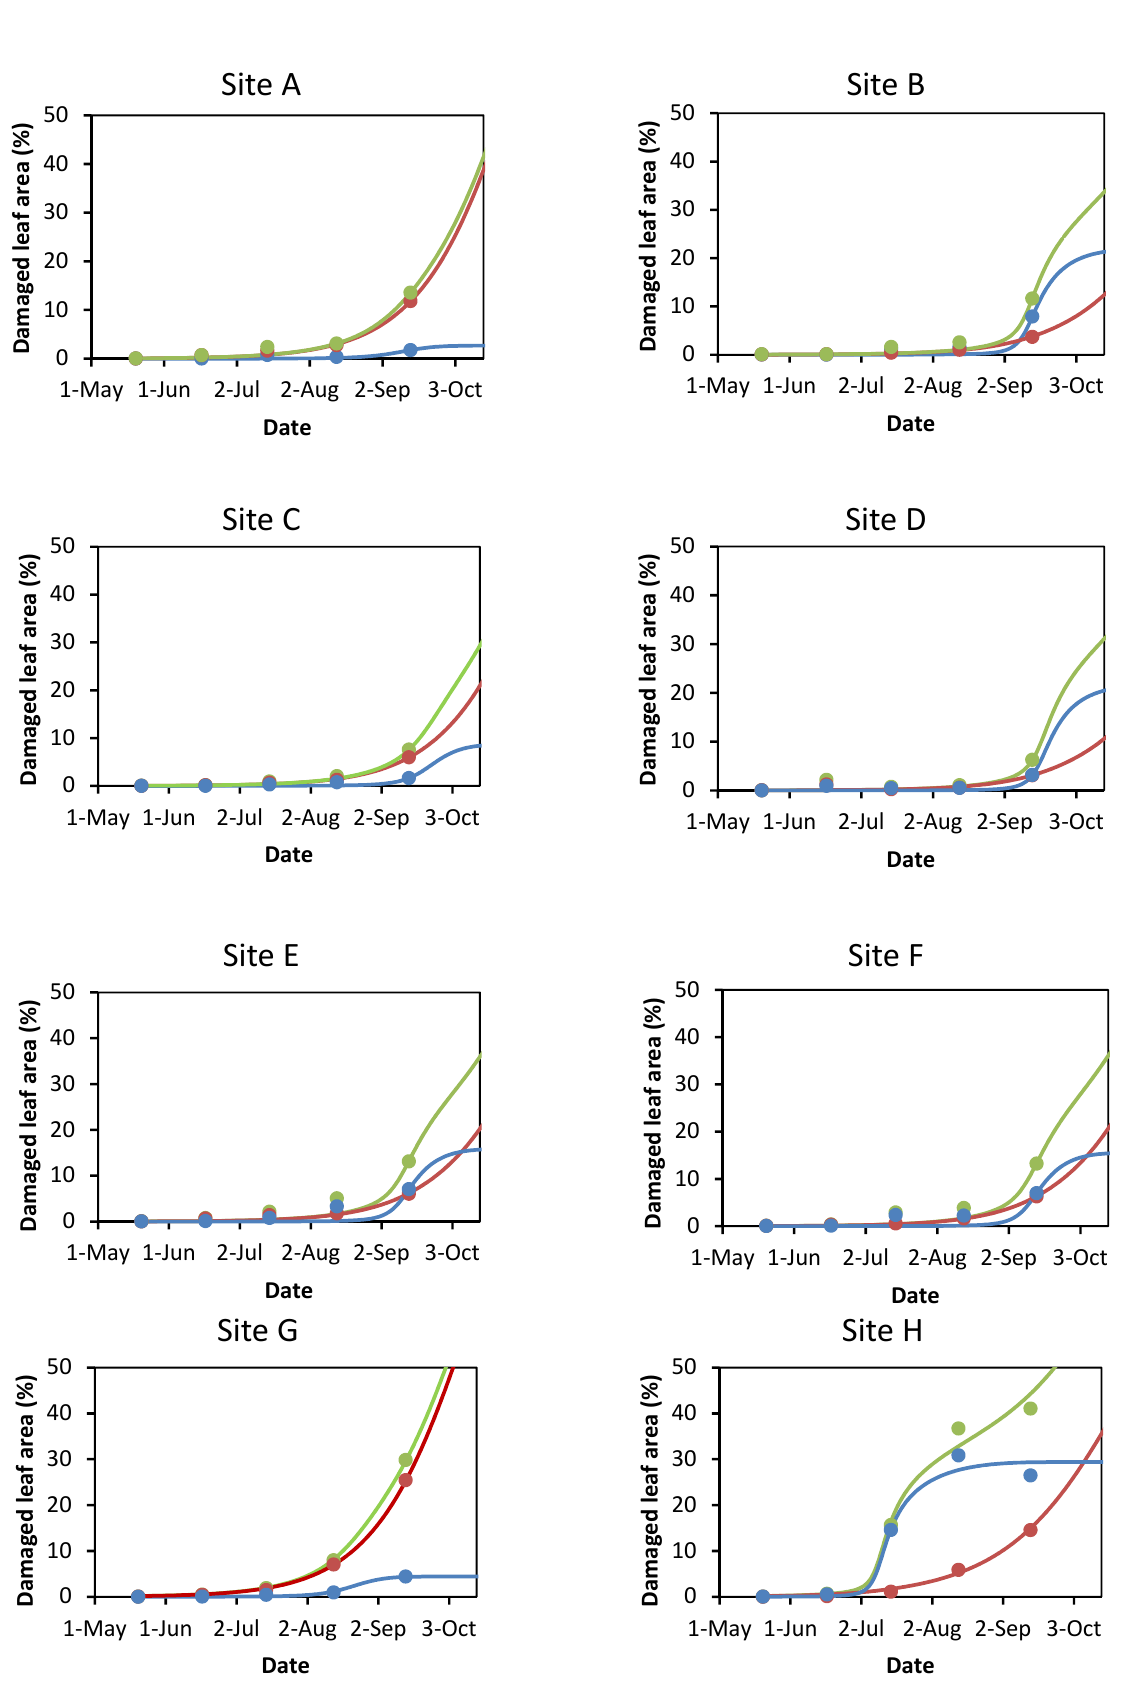
Figure 1. The observed (points) and model predicted (lines) damages during one season at the eight sampling sites (Table 1). First sampling took place around May 20. Each point represents the average damage of 30 leaves attributed to C. ohridella ( blue ) and G. aesculi ( red ) or in combination ( green ).